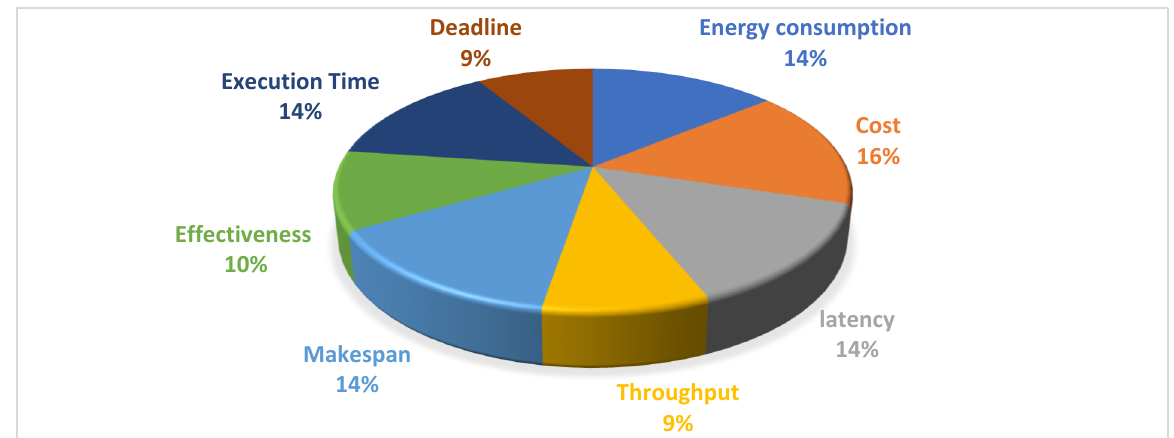
Figure 7. Evaluation parameters of real ‐ time scheduling in IoT applications.